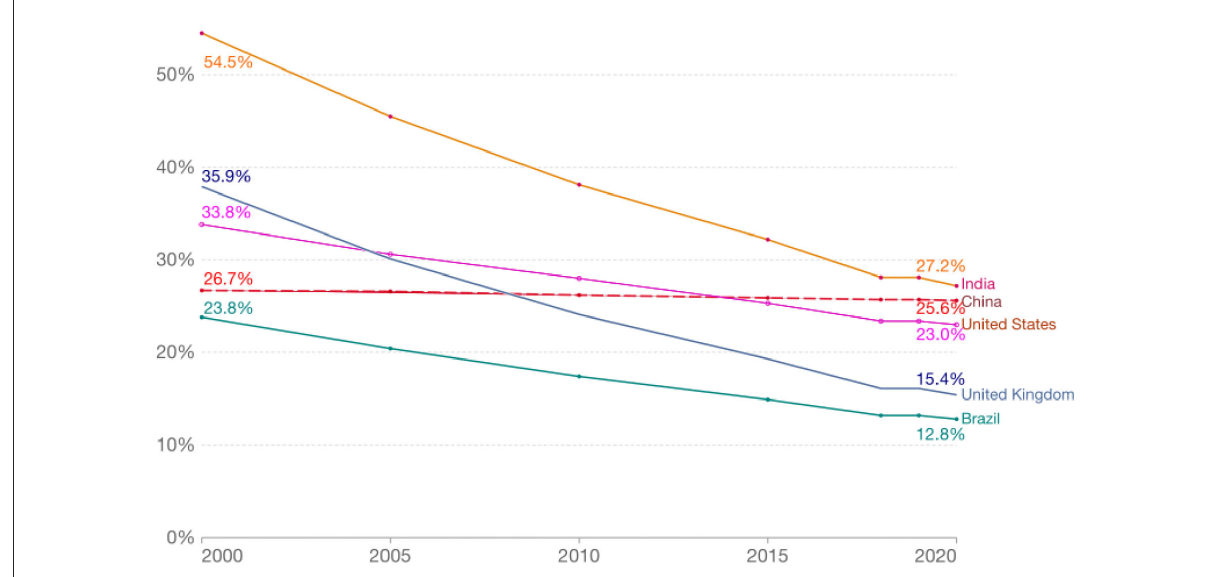
FIGURE1 Percent of adult smokers from each of the selected countries, 2000 and 2020. Data source: The World Health Organization; Adults: people aged 15 years and